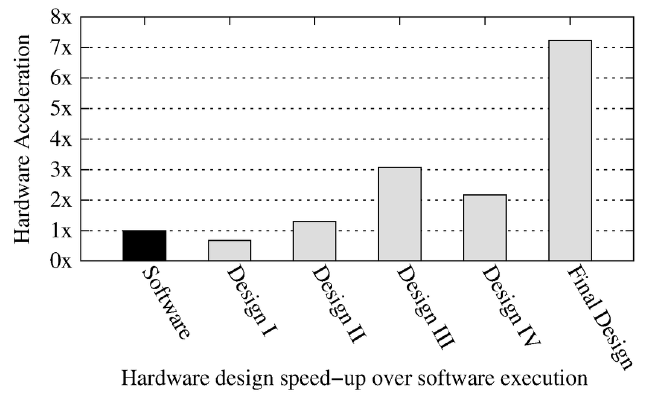
Figure 10. Hardware speed-up relative to software execution. Table 6. Hardware designs power